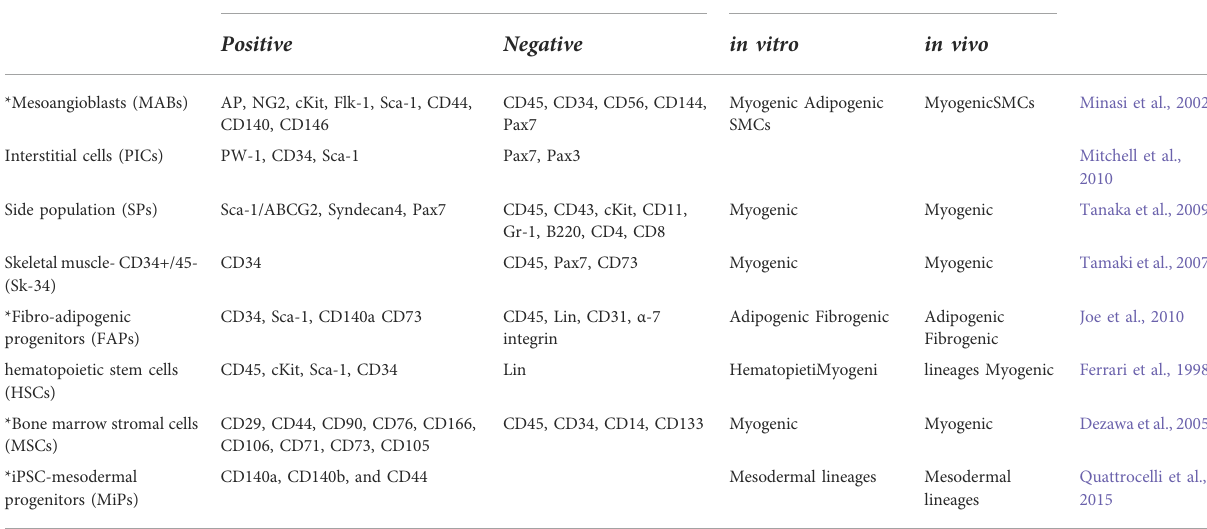
TABLE 1 Adult stem/progenitor cells involved in skeletal muscle regeneration, beside satellite cells and other muscle derived myogenic cells; MABs, mesoangioblasts;PICs,PW1(+)/Pax7(-)interstitialcells;SP,sidepopulation;FAPs,Fibro-adipogenicprogenitors;HSCs,hematopoieticstemcells; MSCs, Bone marrow stromal cells; MiPs mesodermal iPSC-derived progenitors; SMCs, smooth muscle